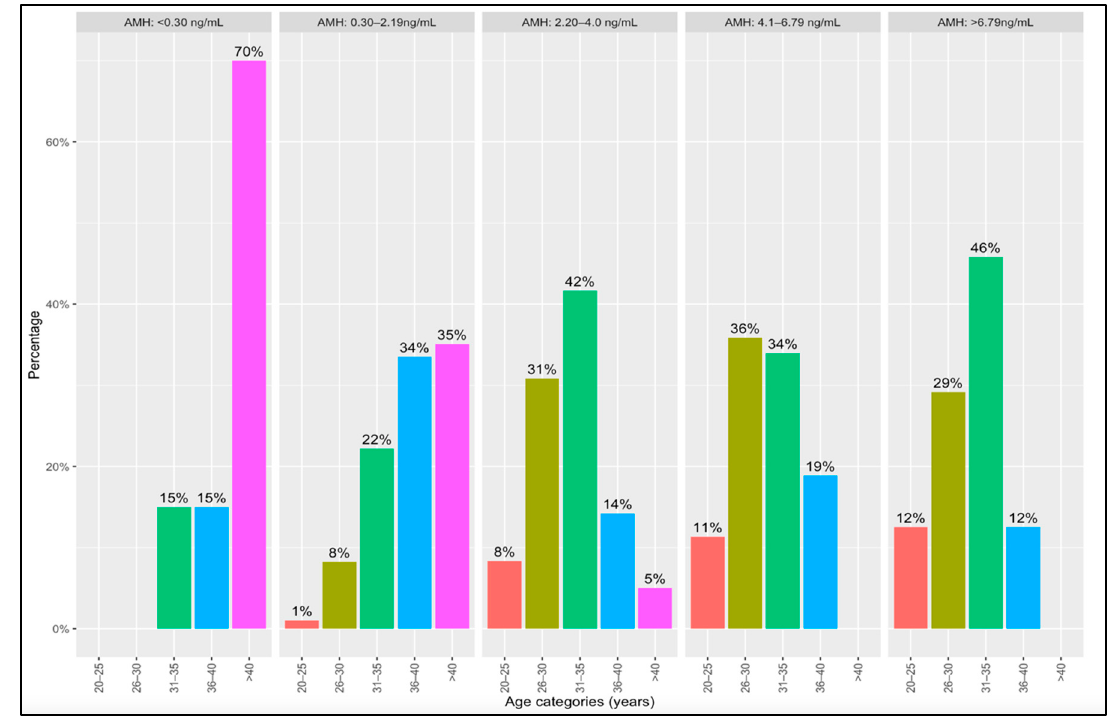
Figure 3. Comparing AMH categories and maternal age categories.